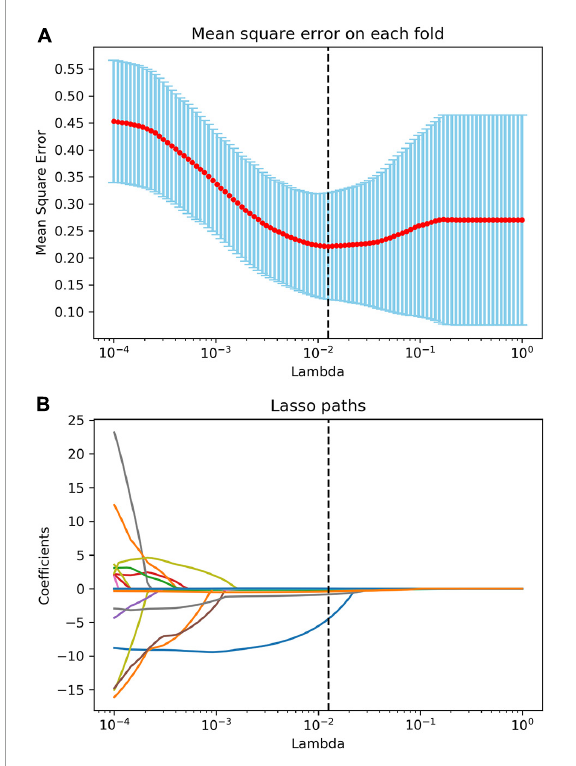
FIGURE4 Radiomics feature selection using the least absolute shrinkage and selection operator (LASSO) algorithm. (A) The mean square error plot for tenfold cross-validation. The optimal parameter λ ( λ = 0.013) in the LASSO algorithm is shown with the smallest mean square error. (B) The coefficient profile plot was produced against the log ( λ ) sequence. At the selected optimal λ value, 11 non-zero coefficients were